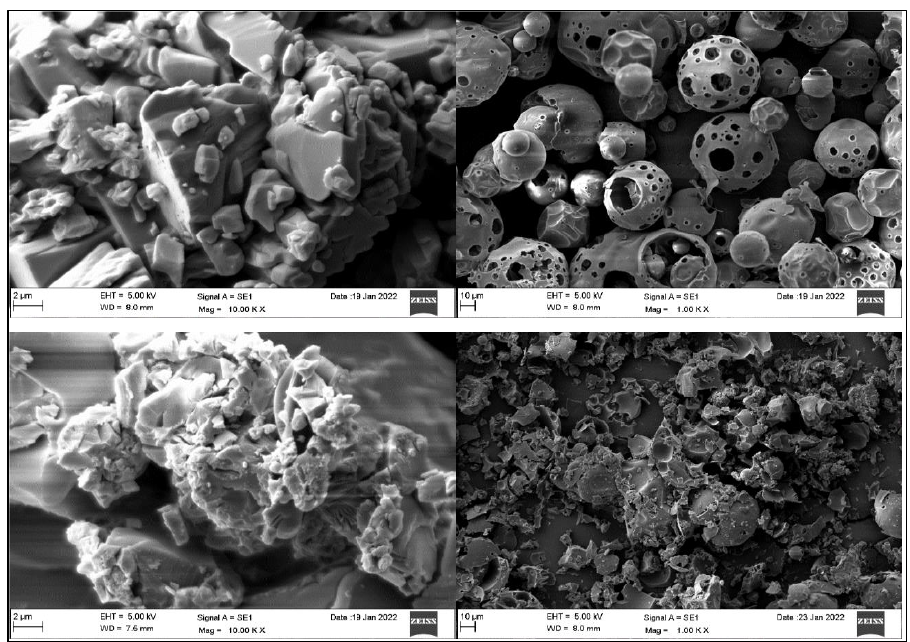
Figure 3. Scanning electron micrograph of pure Chrysin, HP- βCD, Chrysin ternary mixture (CHR-TM), and Chrysin ternary complex (CHR-TC).